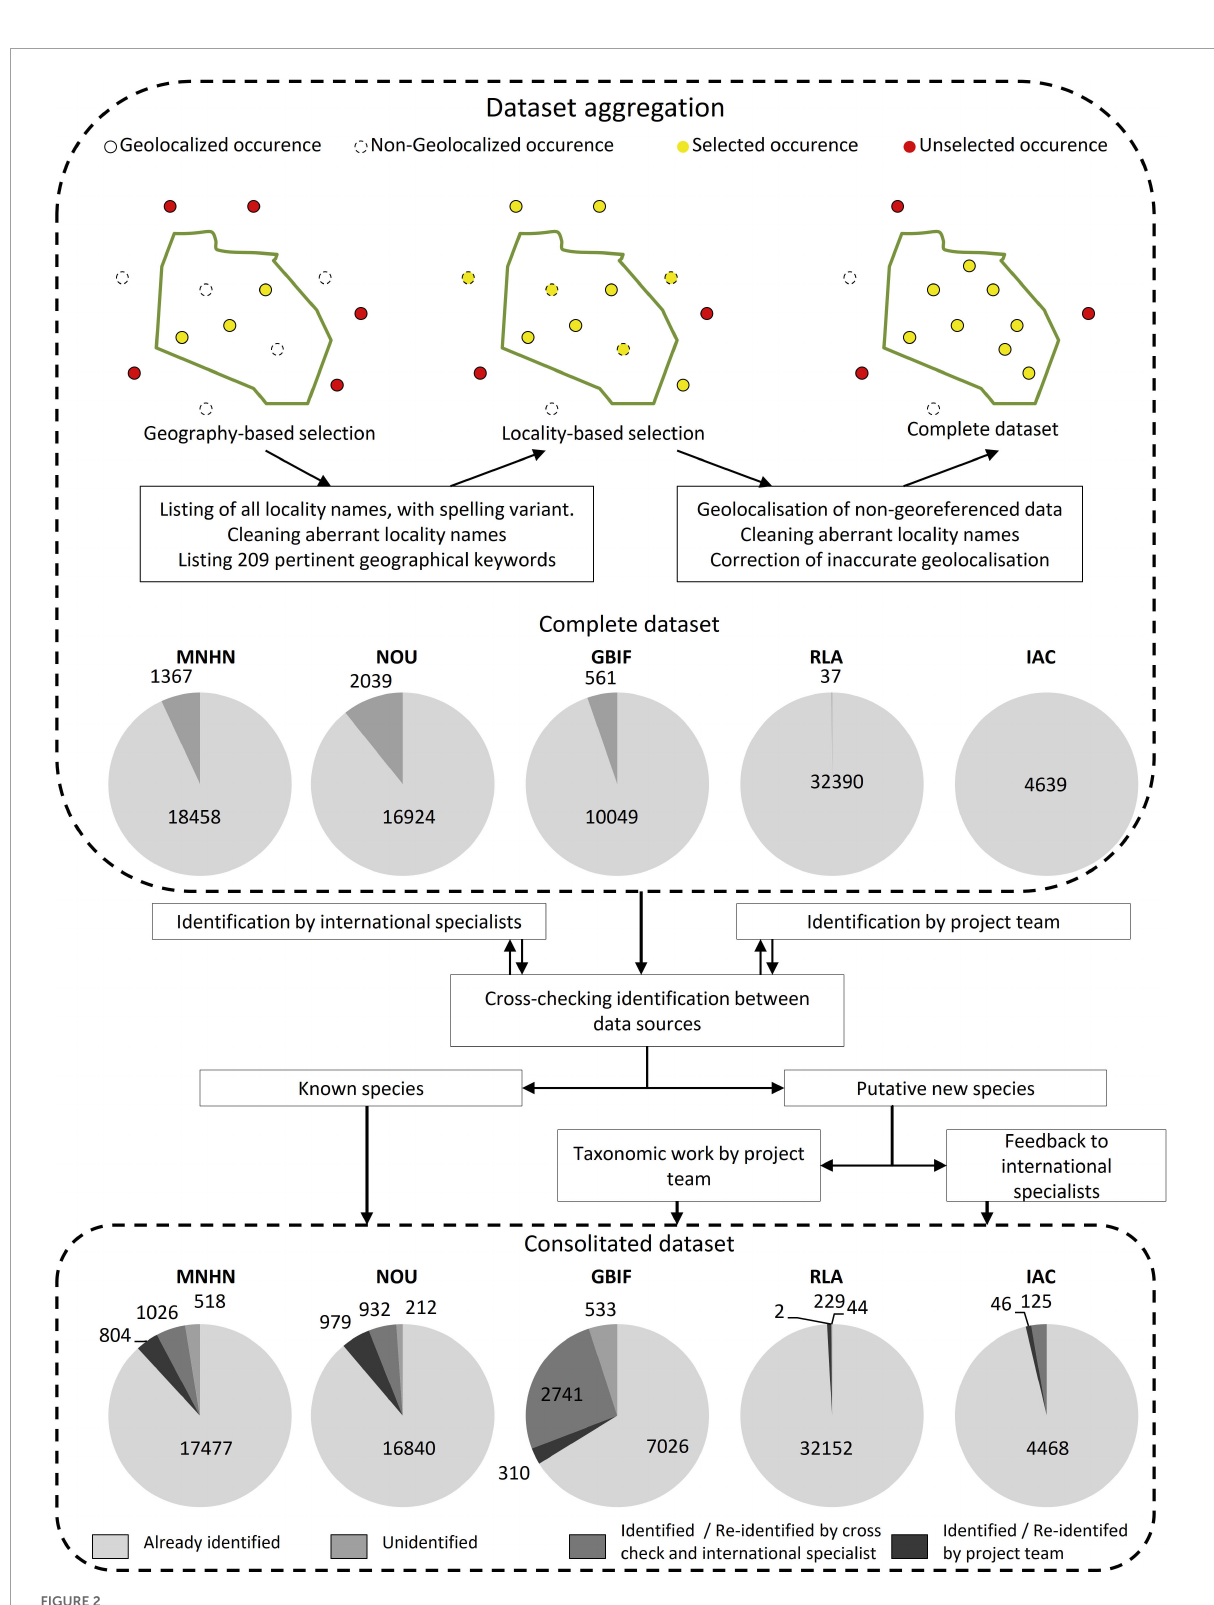
FIGURE2 General workflow for data aggregation and cleaning. Pie chart captions are the same for complete and consolidated datasets, and presented at the bottom.